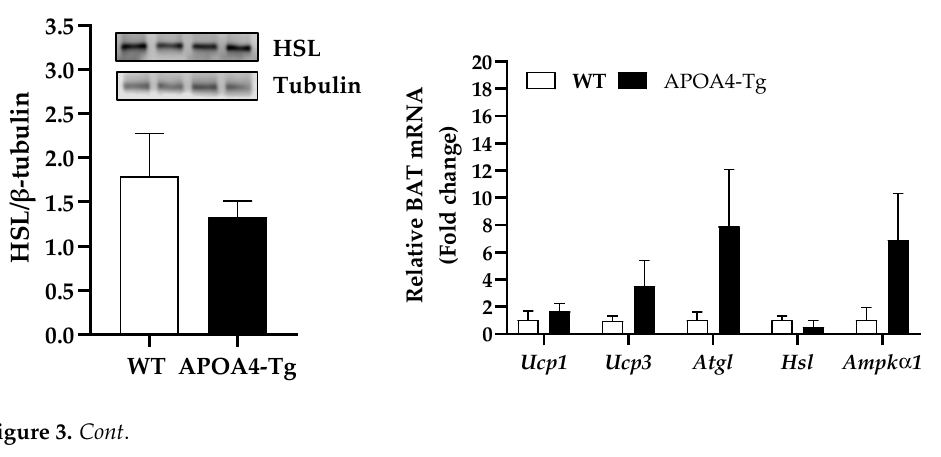
Figure 3. Levels of plasma apolipoproteins ( A ), thermogenic protein ( B ), tyrosine hydroxylase (TH) protein ( C ), adipose triglycerides lipase (ATGL) protein ( D ), hormone-sensitive lipase (HSL) protein ( E ) and mRNA ( F ) in BAT of mice fed HFD for 4 weeks, and weekly body weight ( G ) in WT and APOA4-Tg mice during a 4-week feeding of HFD at 28 °C. Plasma and BAT were collected after a 5 h fast. Plasma APOA4 or APOA1 in WT mice was considered as 100%. Data are expressed as mean ± SEM for 6–8 animals per group. Values with asterisks (*) represent significant differences relative to the WT mice ( p < 0.05).